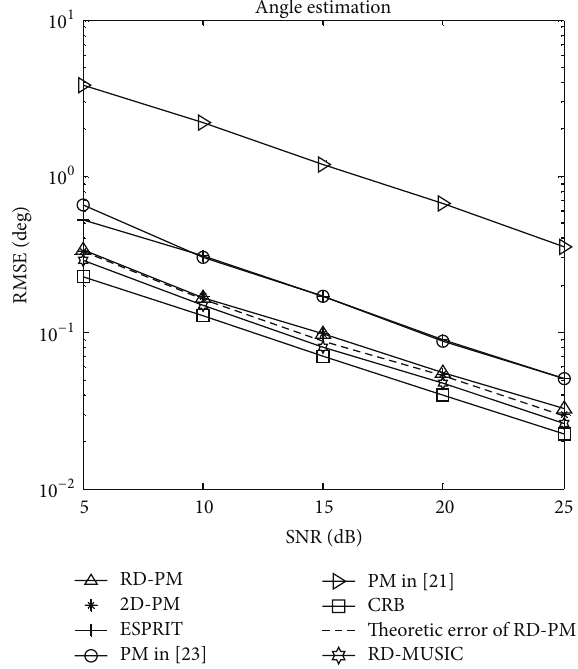
Figure 6: Angle estimation performance comparison ( 𝑀 = 8 , 𝑁 = 10 , 𝐽 = 120 , and 𝐾 = 2